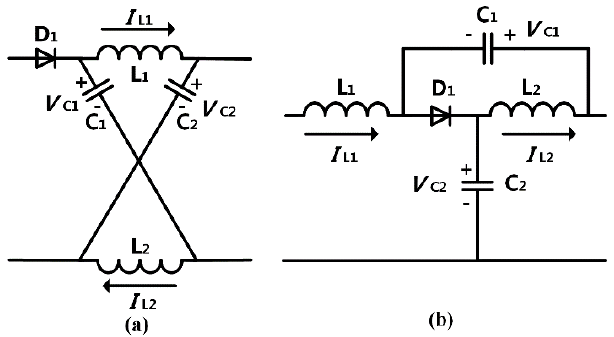
Figure 5. Topologies of Z-source ( a ) and q-Zsource ( b ).